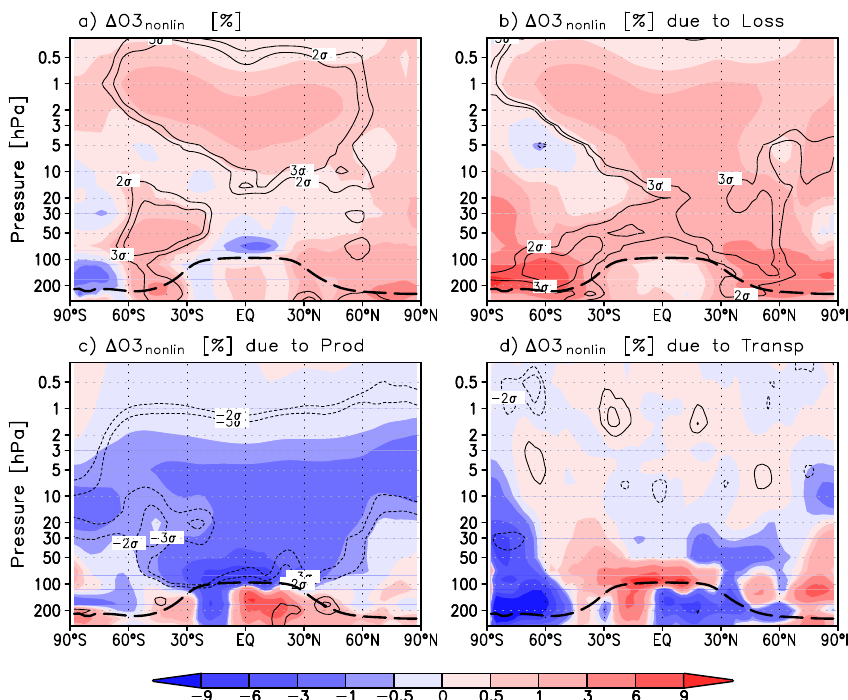
Figure 2. Latitude-height section of the nonlinear contribution to the annual mean ozone change (a) between 1960 and 2000 in percent and the separation into the contributions from ozone loss (b) , ozone production (c) and ozone transport (d) . Red/blue shading indicates positive/negative changes. The contour lines indicate the regions where the changes are larger than ± 2 σ and ± 3 σ . The bold dashed line shows the mean tropopause location of the R1960 simulation for the annual mean. Note that the contributions from chemistry (b+c) and transport (d) do not exactly add up to the total (a) because of the residual